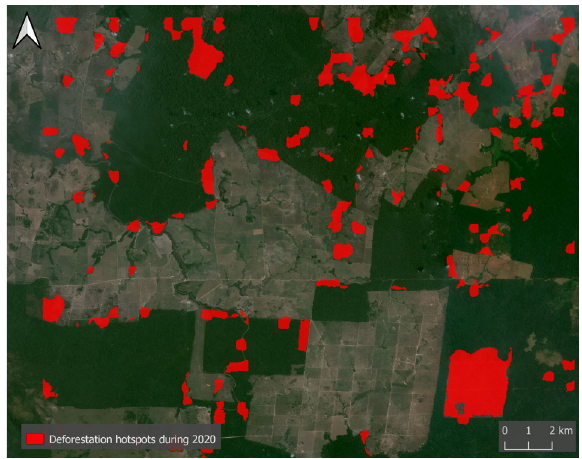
Figure 9. Forest loss in 2020. (Basemap - September 2020 (monthly NICFI dataset, distributed by Planet Labs.)